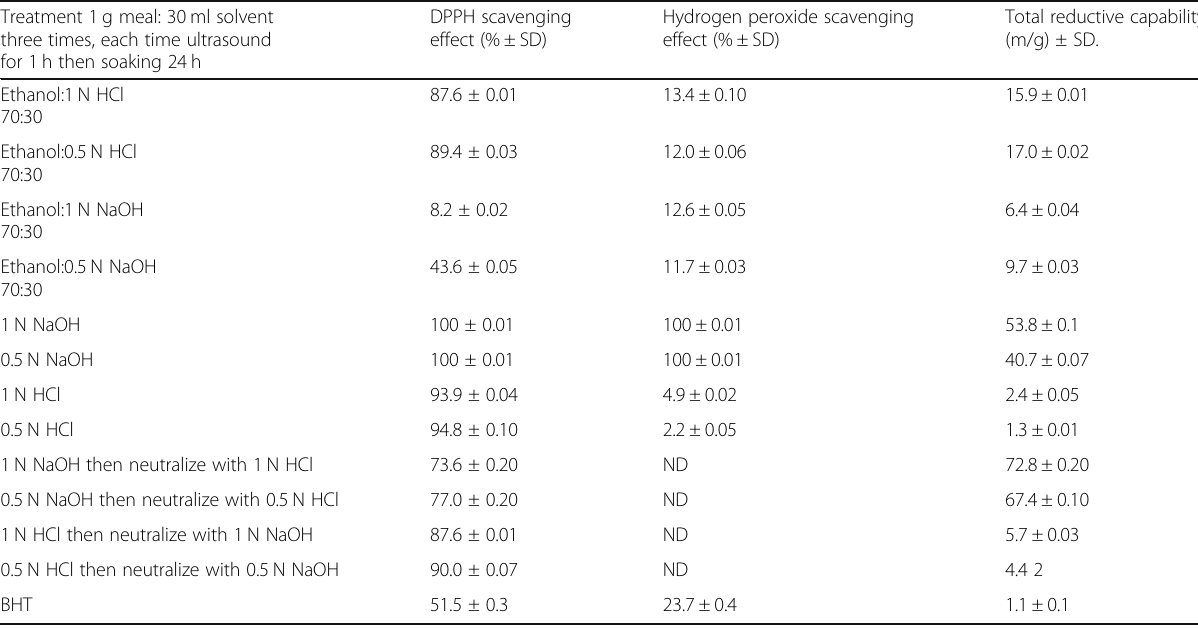
Table 3 Antioxidant activity of jojoba hull extracts at room temperature Treatment 1 g meal: 30 ml solvent three times, each time ultrasound for 1 h then soaking 24